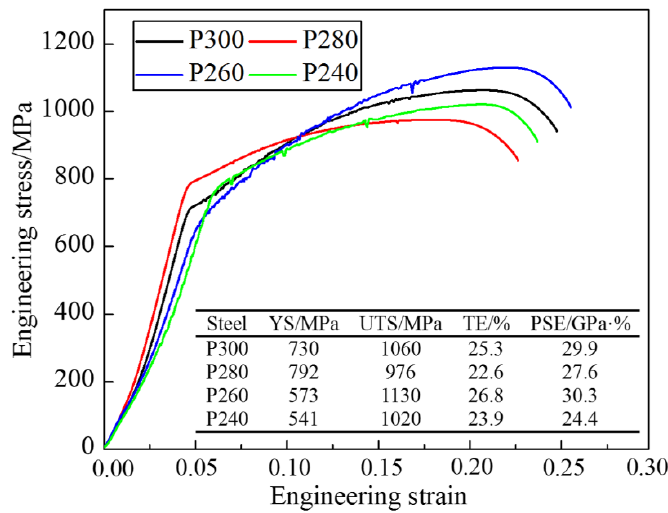
Figure 6. Stress – strain curves and mechanical properties. Figure 6. Stress–strain curves and mechanical properties.